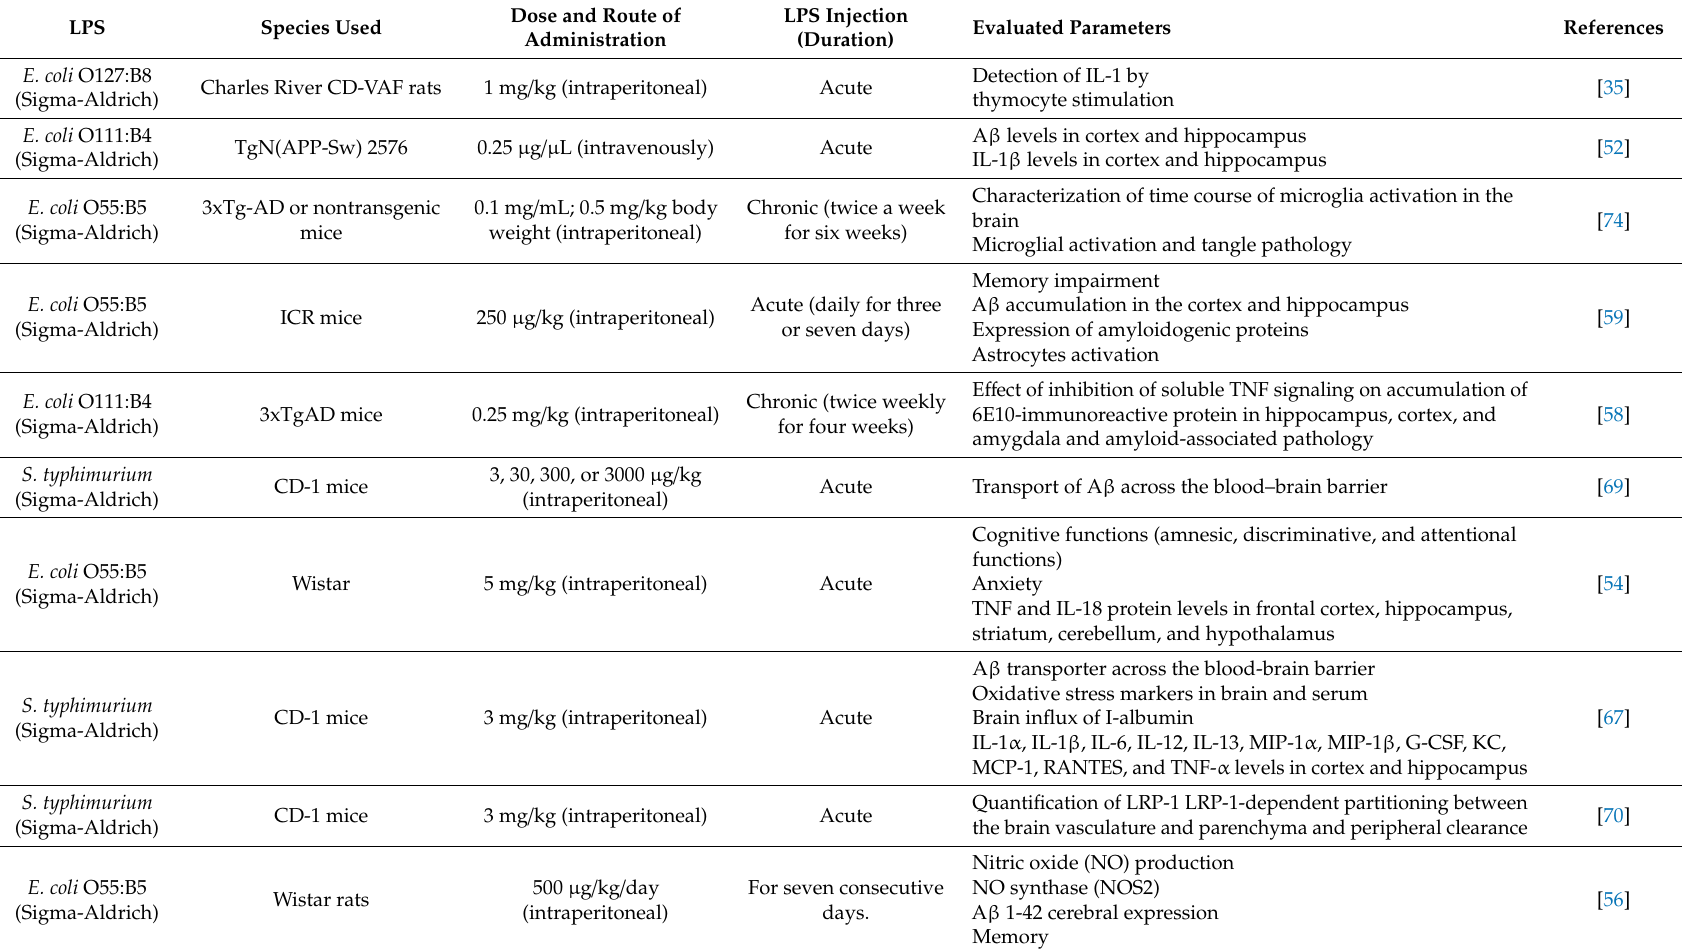
Table 2. LPS source, species used, dose and route of administration, duration, evaluated parameters of models of systemic LPS challenges for the elucidation of